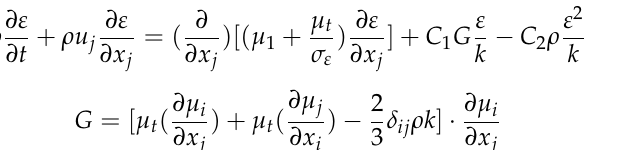
Figure 4. Computational grid. The boundary conditions are as follows: the nozzle exit is set as the velocity inlet; the turbulent kinetic energy at the inlet is 1% of the average kinetic energy of the incoming flow; pressure far field conditions are given for outer boundary; isothermal wall assump- tion and no slip boundary condition are adopted on the solid wall of the projectile. In actual operation of the attitude control engine, two supersonic fluidic elements work at the same time to provide two parallel jets in the same direction. Figure 5 is a schematic diagram of the geometric model of the two parallel jets. The geometry model ,